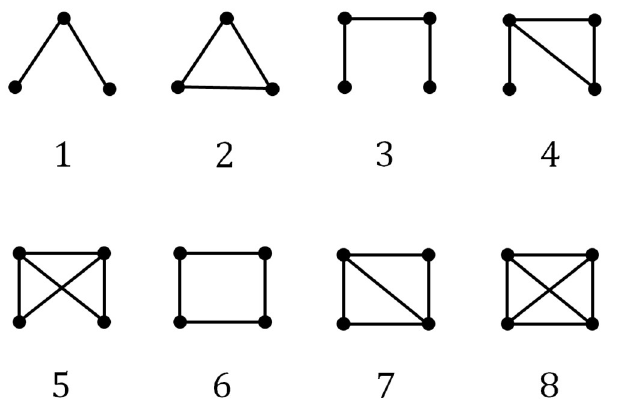
Fig 4. Motifs used to embed citation